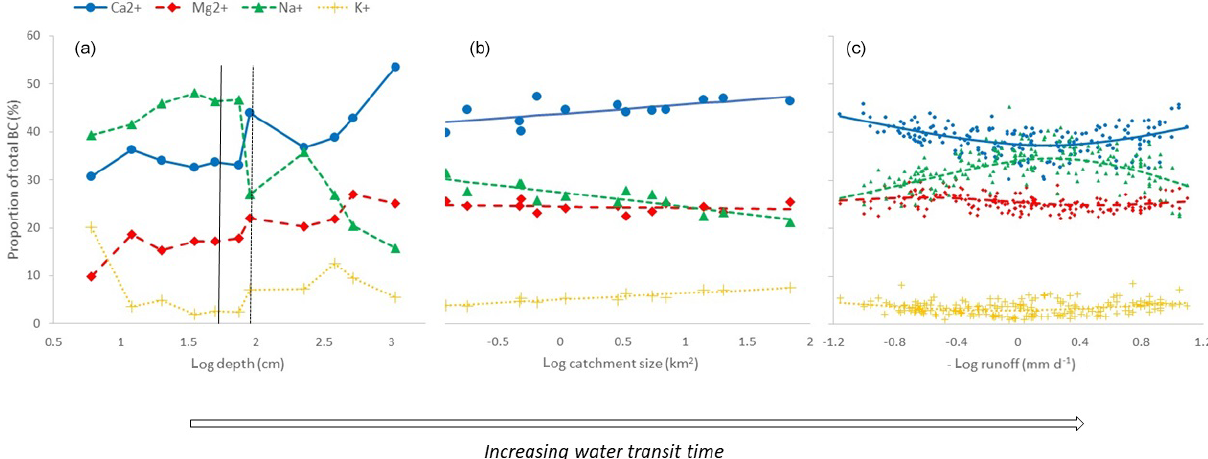
Figure 4. Base cation ratios (%) plotted against different proxies for water transit time. (a) Ratios in soil water samples from a soil profile 22m from stream C2, sampled from a depth of 6 to 10.7m below the surface. (b) The ratios in stream water samples from 2016 ( N = 19–25) from the Krycklan Basin plotted against subcatchment size (range of 0.12–67km 2 ). (c) The ratios in stream water samples from 2003 to 2012 from stream C2 (0.12km 2 ) plotted against the negative logarithm of